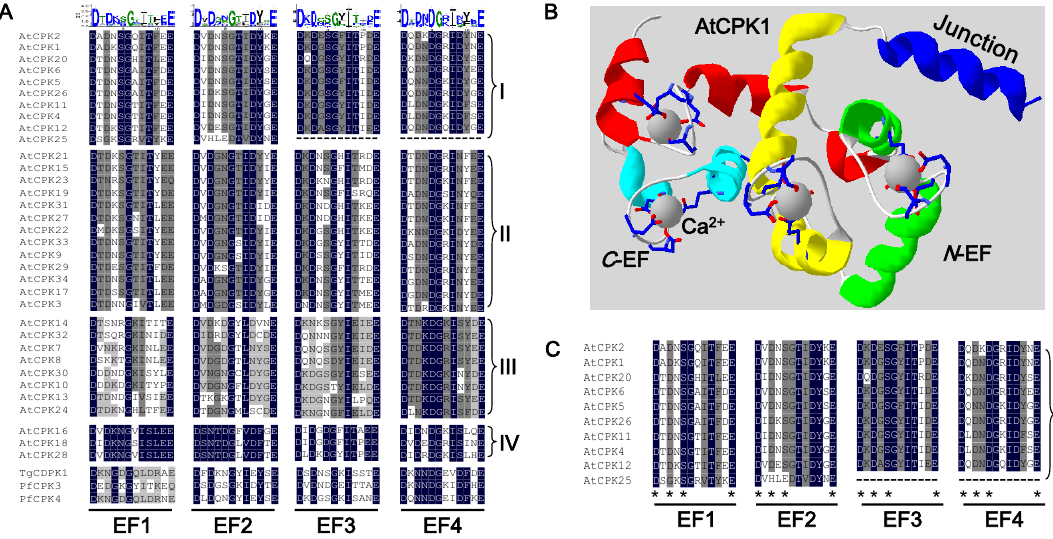
Figure 3. Amino acid sequence analysis of Ca 2+ -binding sites (the loop segment of the EF-hand) in AtCDPKs. ( A ) The amino acid sequences of four EF-hands in AtCDPKs, TgCDPK1, PfCDPK3 and PfCDPK4. The black line in subgroup I represents EF-hand deficiency of CPK25. ( B ) The monomeric structure of CPK1 J-CaM-LD region. The crystal structure of J-CaM-LD (PBD entry No. 2AAO) downloaded from PDB database is visualized by Swiss-PdbViewer (https://spdbv.vital-it.ch/). The Junction region that contains 31 amino acids is showed by a blue ribbon, while the helices of four EF-hands (EF1~EF4) are displayed by yellow, green, red and brilliant blue ribbons, respectively. The binding loops are displayed by grey bars. Each calcium ion binding to the loop is shown by a gray ball and the chemical bonds accountable for Ca 2+ -loop interaction are indicated by sticks. ( C ) Amino acids of four EF loops in charge of Ca 2+ -binding in CPK1 (or subgroup I) are indicated by asterisks.